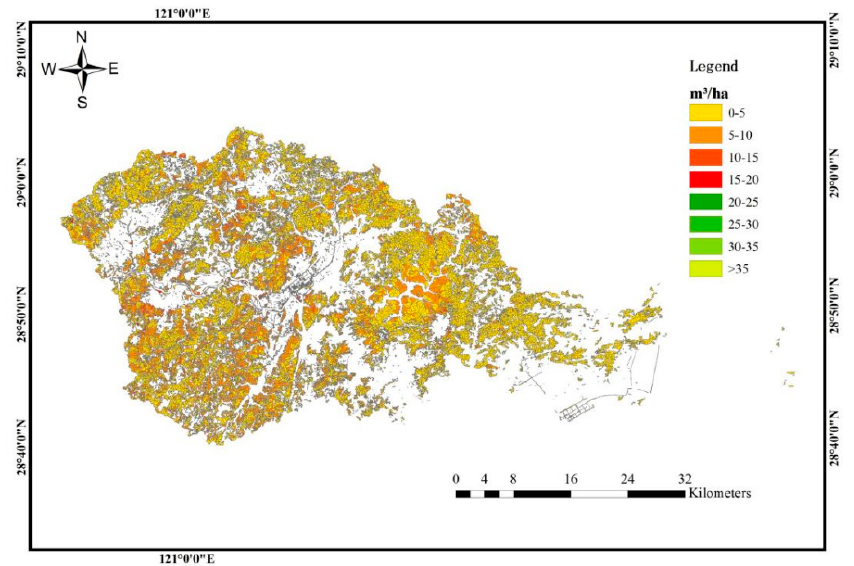
Figure 3. Distribution map of forest growing stock per hectare of the sample plots.